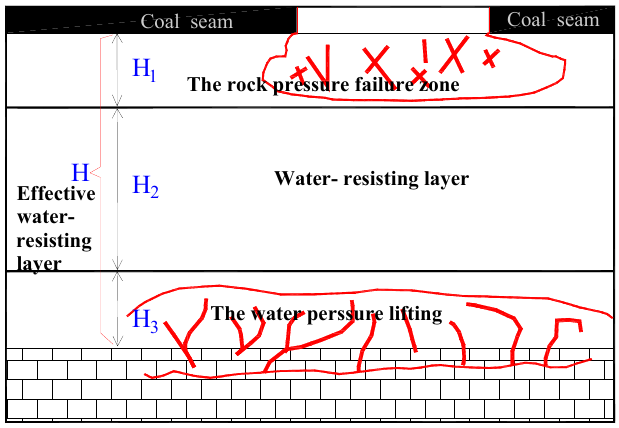
Figure 4. Schematic of the “lower three zones”.